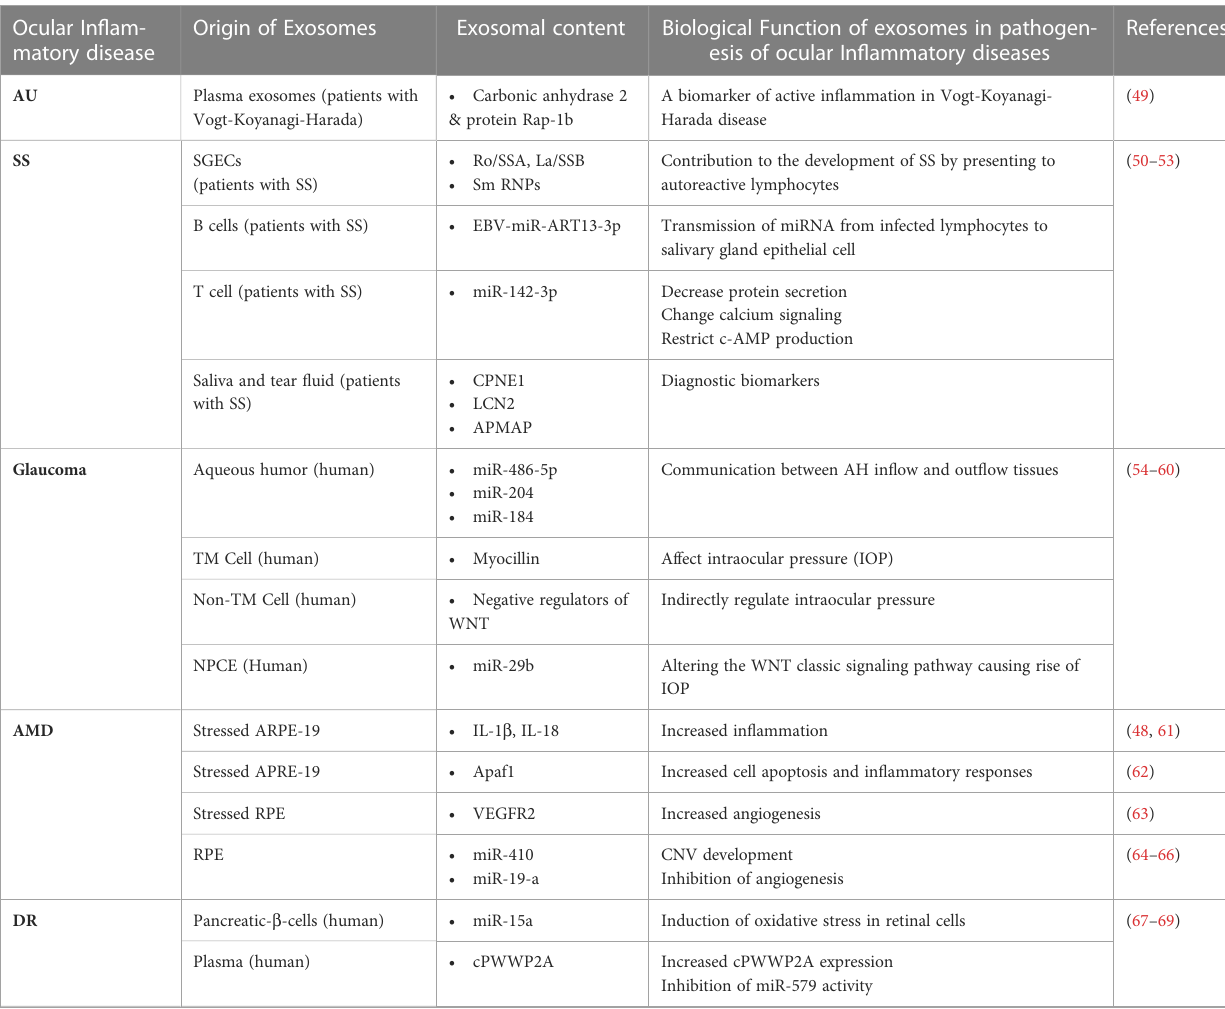
TABLE 1 Biological function of exosome in the pathogenesis of ocular in fl ammatory diseases. Ocular In fl